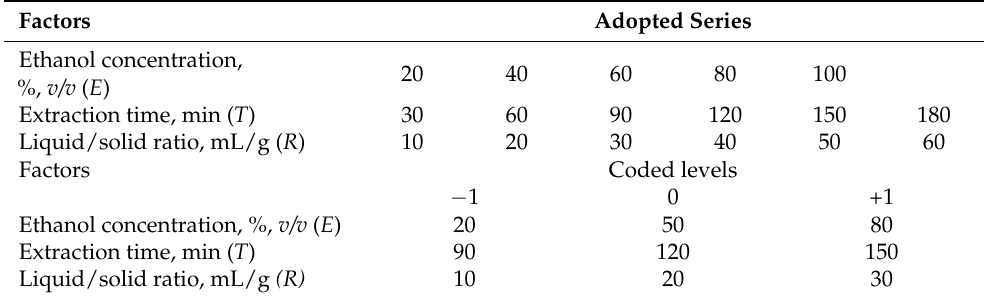
Table 1. Series adopted for the factors in the preliminary study, coded, and real values for central composite design (CCD) of PP